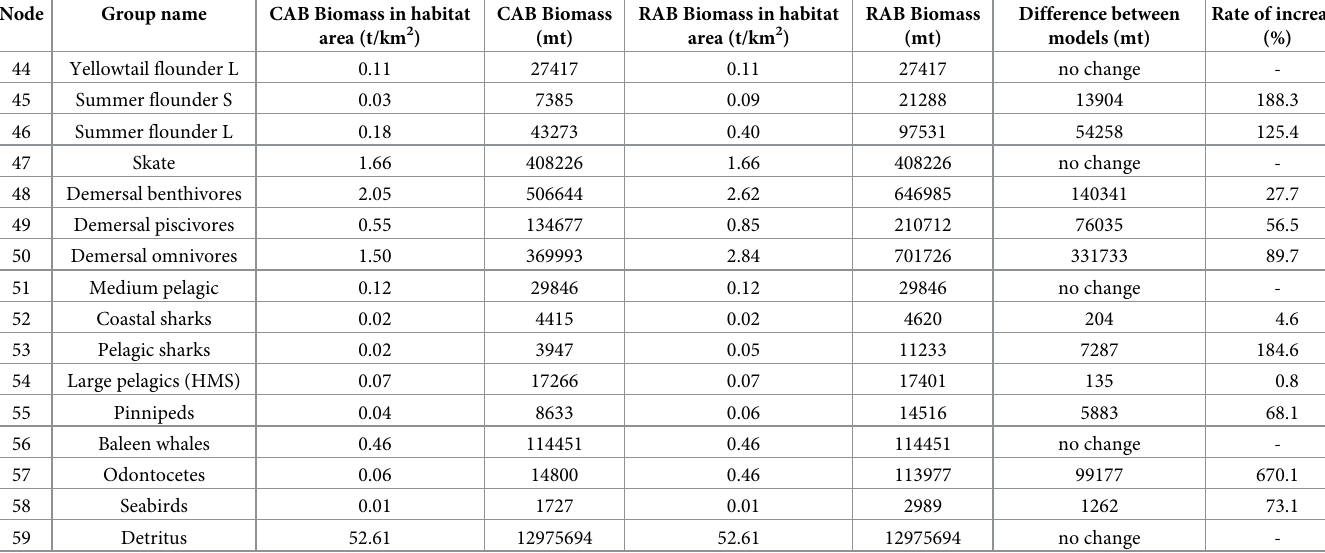
increase of 97.5%, the equivalent of 255,477 metric tons. For the shrimp group, there was an increase of 54% or 261,041 metric tons. Species of conservation concern benefitted from the augmented forage base. Toothed whales, pinnipeds, pelagic sharks and seabirds, together, showed a biomass increase of 69% or 113,948 metric tons. Toothed whales (Odontocetes) alone would potentially increase by 99,177 metric tons. The contrast between the CAB and RAB models trophic level decompositions shows the magnitude of the change in biomass flows between the scenarios. The trophic level decomposition analysis shows the difference in biomass flows from each discrete trophic level and illustrates the differences in the magnitude of the trophic composition of species of conser- vation concern in NEUS LME, and how the new biomasses increase the allocation of the frac- tions of the flow. We separated key functional groups to present the magnitude of energy flow changes attributed to increased anadromous alosine biomass, and how the restoration of only a few rivers promotes additional production across multiple key species (Fig 5, Table 4). Table 4 shows the allocations’ differences between CAB and RAB models, used to generate Fig 5. The keystoneness analysis, a measure of network connectivity, also revealed differences between the two models. For the CAB model, the top five species ranked from highest to low- est on the keystone index were: micronekton (0.044), macrobenthos crustaceans (0.017), coastal sharks (0.0039,), large copepods (0.0032) and phytoplankton (-0.041). The RAB model’s first- and second-ranked functional groups were the same as the CAB model (micro- nekton = 0.00668, and macrobenthos crustaceans = -0.00124); however, large copepods (-0.00389) and phytoplankton (-0.0393) occupied the third and fourth places, respectively, and Odontocetes (-0.0463) occupied fifth place (Fig 5). Among the groups under the forage fish category, the anadromous alosine group was the one that showed the most considerable changes in keystoneness index, increasing twelve positions on the rank, from fifty-third place on CAB to forty-first place on RAB model. Anchovies were the component of the for- age fish species that ranked the highest, with a rise of two steps on the keystoneness ranking (CAB KS = -0.123 [rank 8], and RAB KS = -0.067 [rank 6]). Atlantic herring also showed 1 1